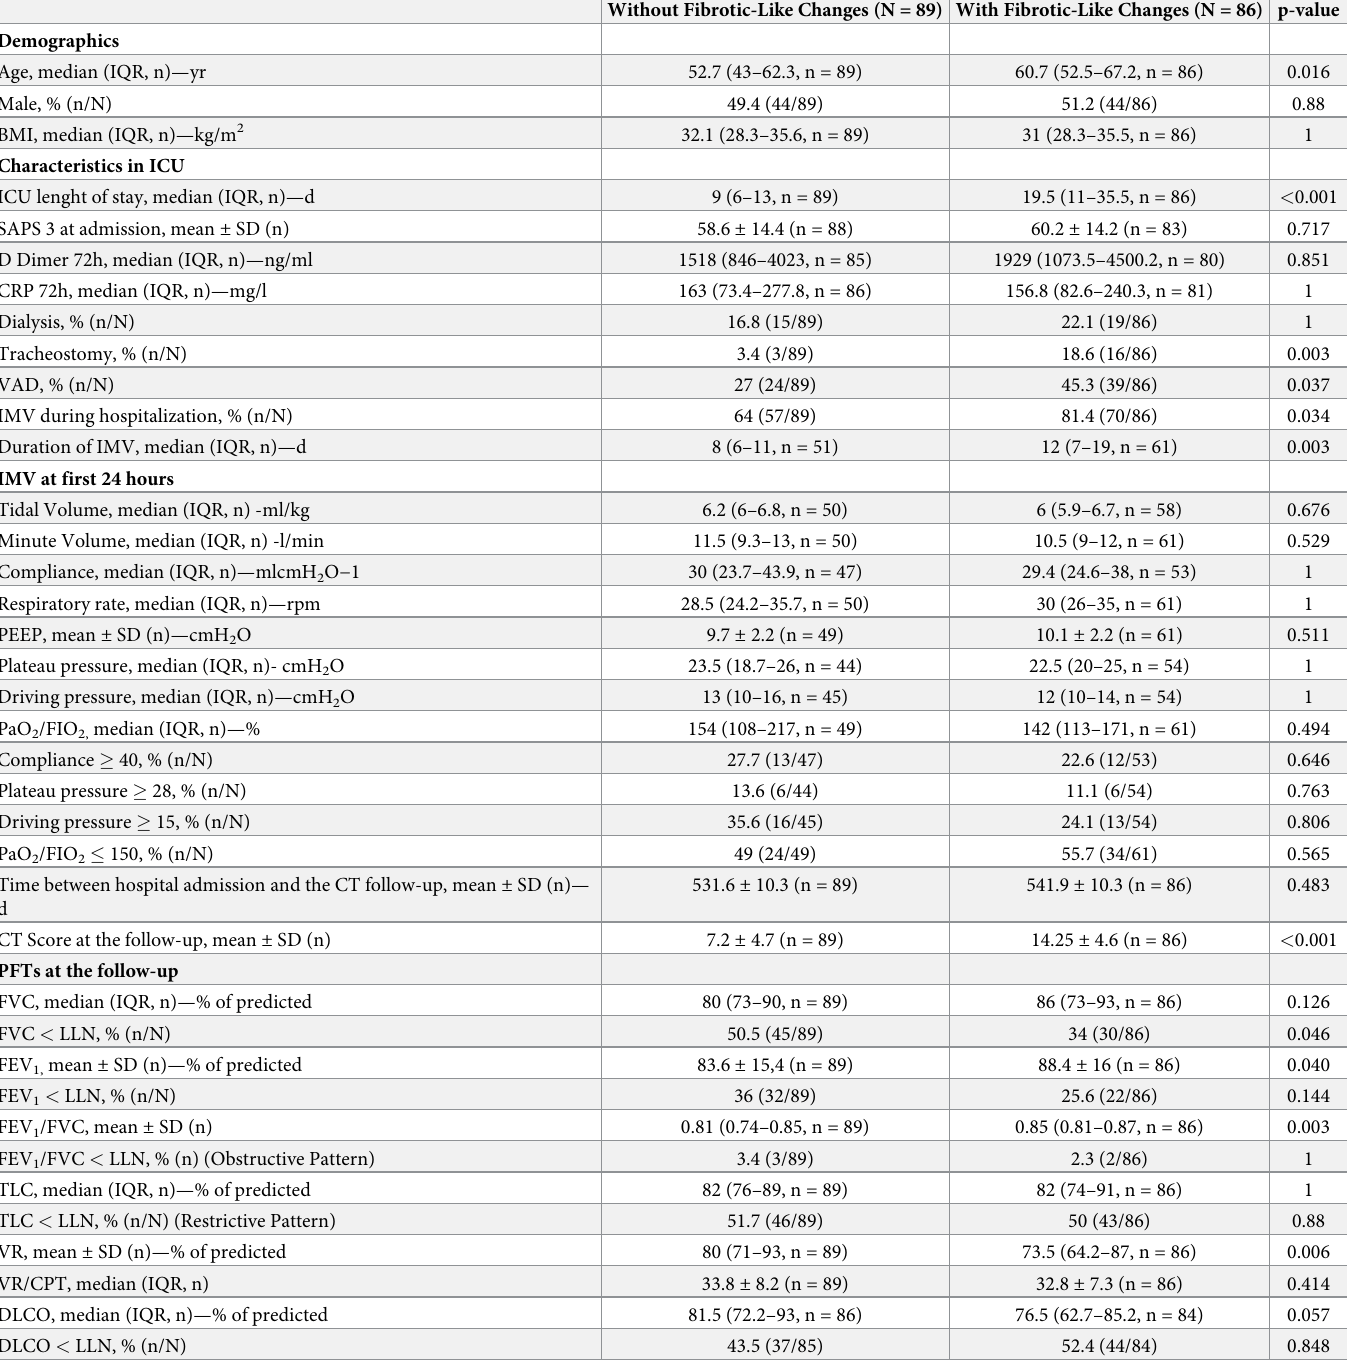
Table 3. Demographic and clinical characteristics of patients with completed chest CT and lung function results stratified by chest CT lesion